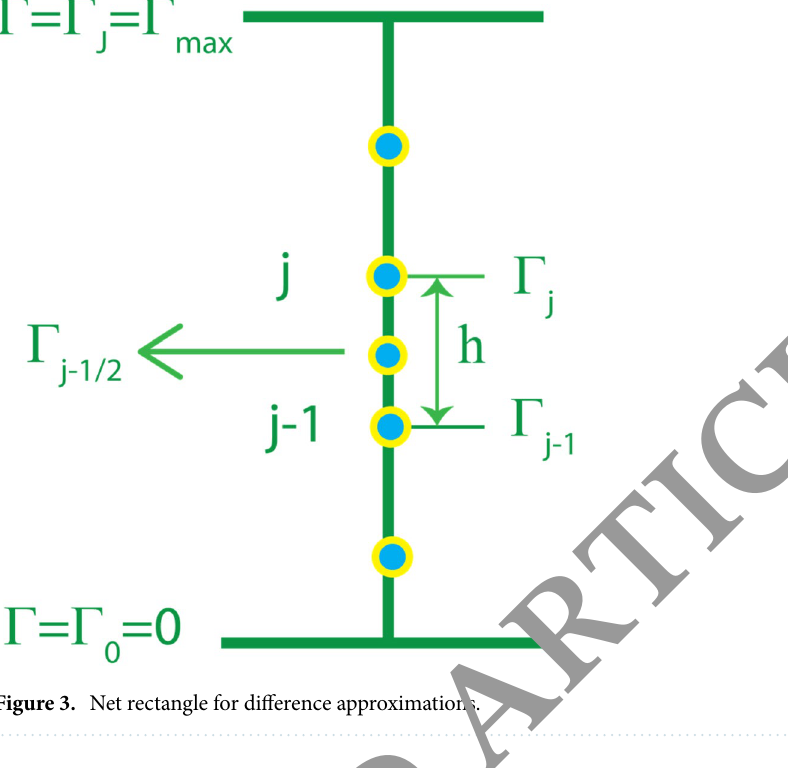
Figure 3. Net rectangle for difference